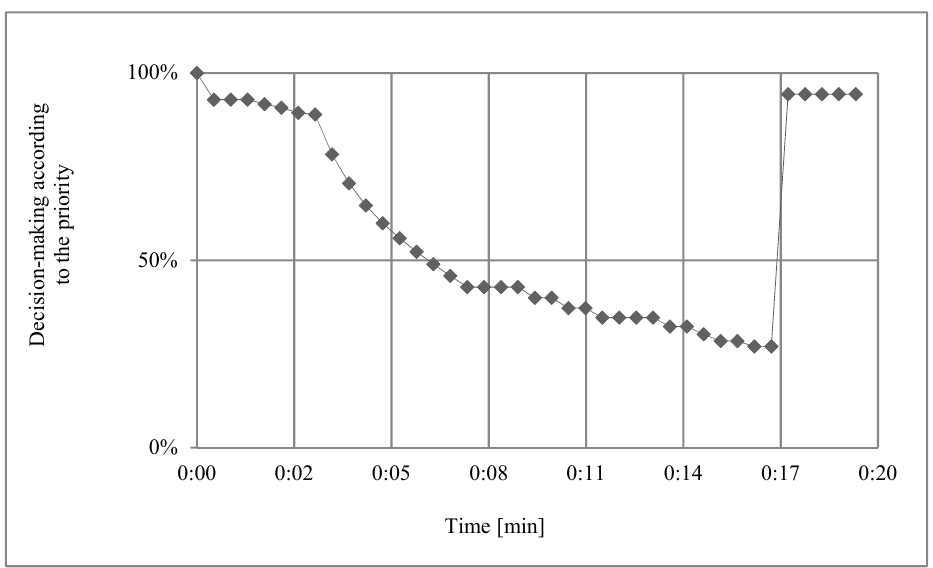
Figure 4. Graph of the probability of rational action taking against the duration of the simulation, in relation to scenario 2.